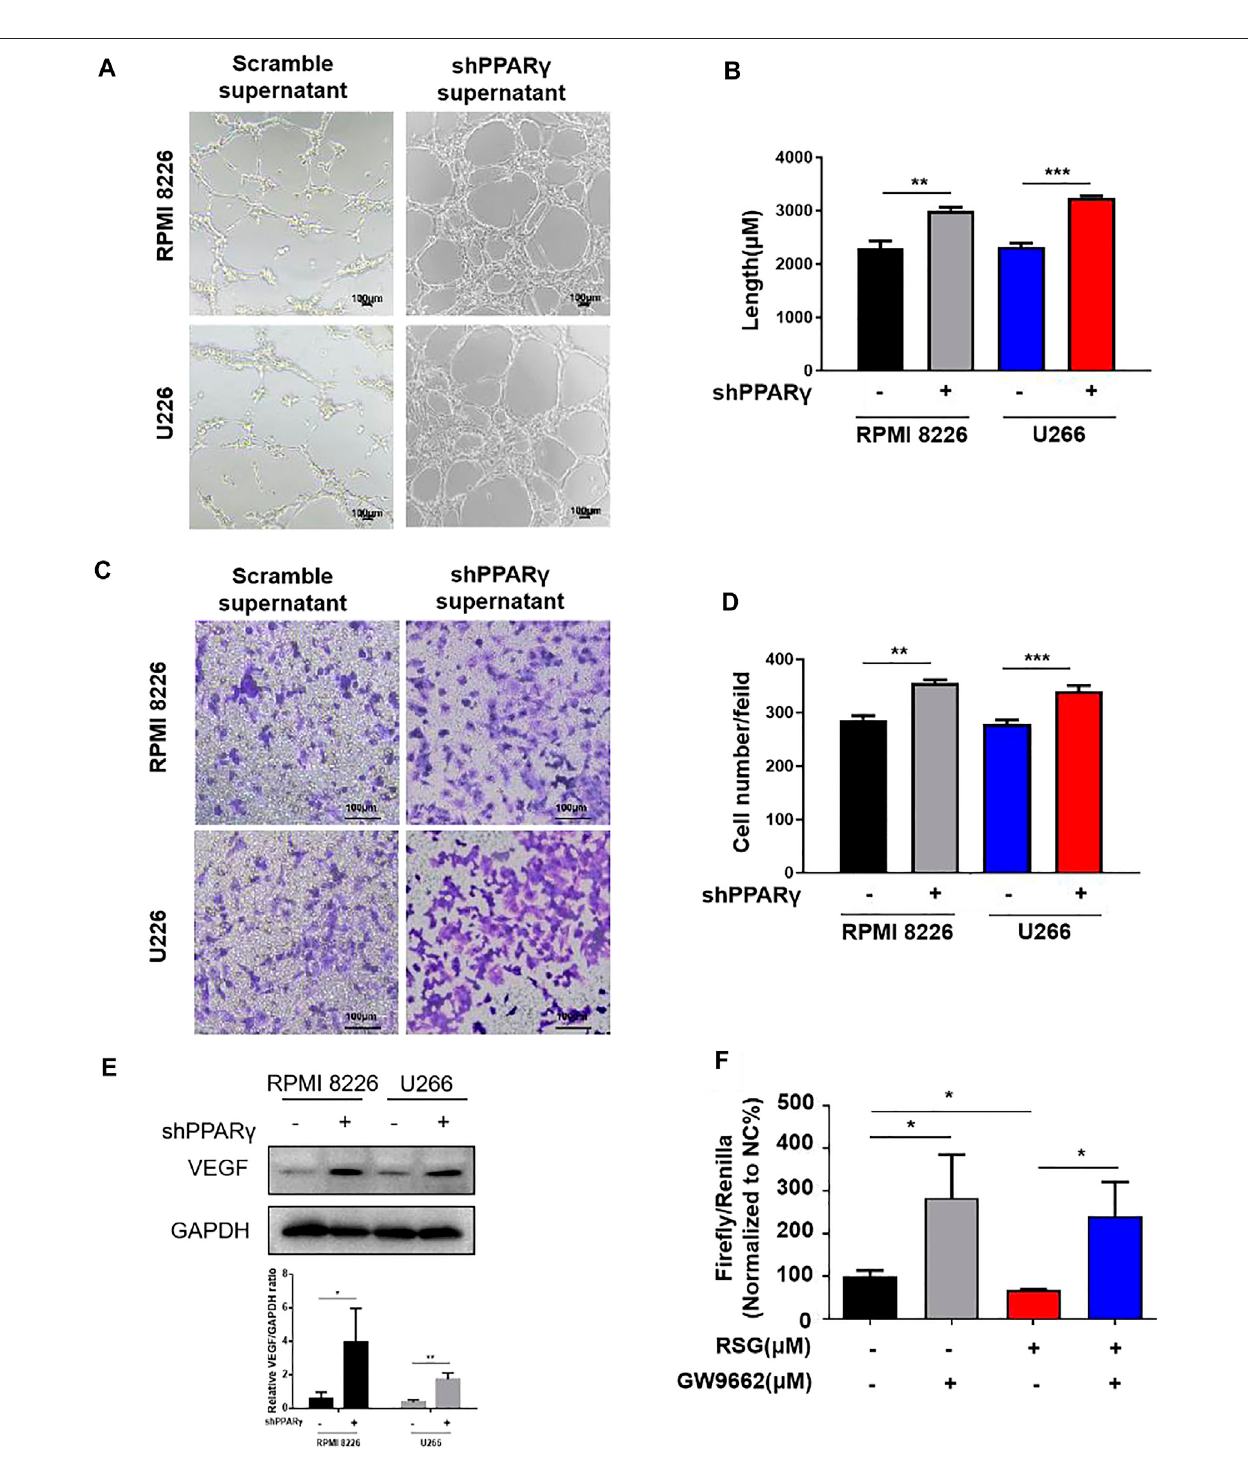
FIGURE 4 | PPAR γ knockdown MM cells promote MM-induced angiogenesis. (A – D) Tube formation experiment and HUVEC migration experiment were treated bytheMMsupernatantwithorwithoutPPAR γ knockdown. (E) ProteinlevelofVEGFwasmeasuredbyWBatMMcellPPAR γ -knockdownornot. (F) Luciferasereporter gene experiment detects the transcriptional activity of PPAR γ when treated with agonist (RSG) and antagonist (GW9662).